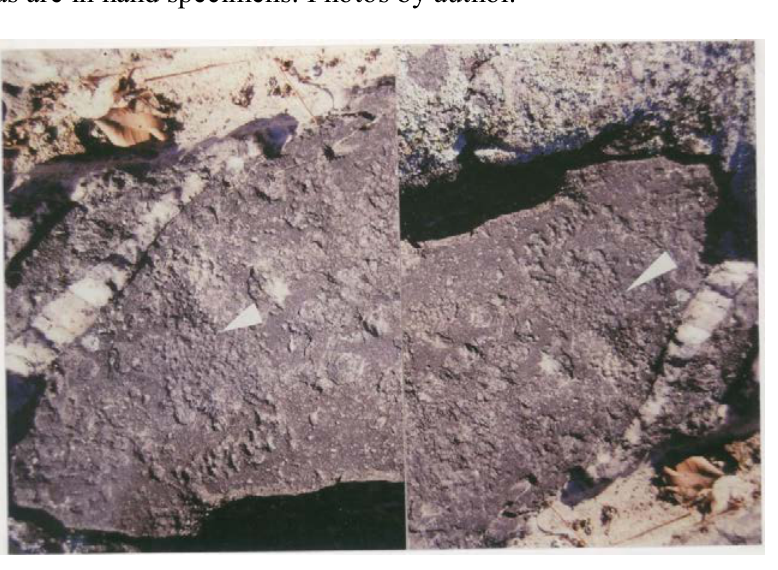
Figure 10. Superimposed images of a lanceolate, concave-based projectile point on the main panel at the Hensler Petroglyph Site. This unprecedented image is about the same size (8.0 cm) as are in hand specimens. Photos by